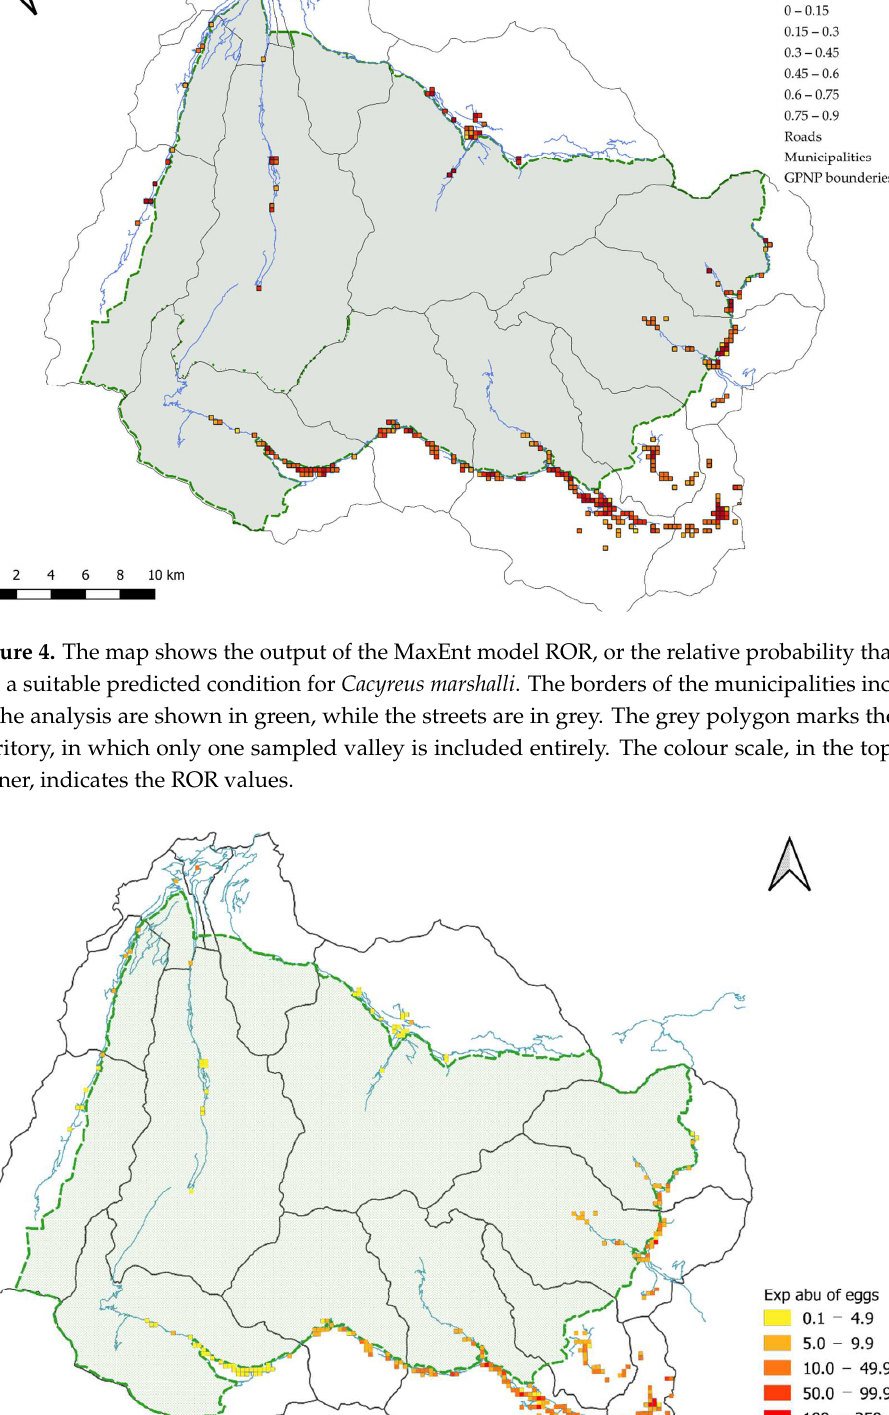
Biology 2022 , 11 , x 12 of 22 examined the residuals, fitted values and observed data of the three models. The graphical fit assessment highlighted that the ZIP model had a much better predictive ability than the NB and P models (for details, see Figure S2). Moreover, the ZIP model was the only model to pass the goodness of fit test for chi-squared statistics ( p = 0.06) and, considering the many zeros characterising our egg counts (zeros = 80%), we felt confident in selecting the ZIP mixture as a suitable distribution for abundance. Although the ZIP model adequately fitted the data, the goodness of fit test showed weak model robustness, as highlighted by the c-hat parameter (ĉ = 2.68), too. We therefore used calculated overdispersion (OD) to multiply the variance–covariance matrix of the ZIP model in order